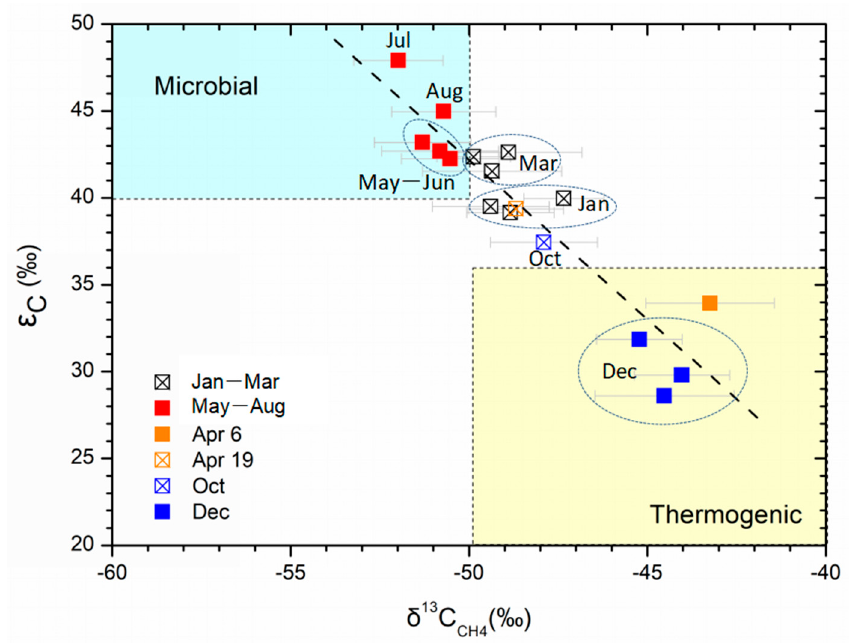
Figure 8. Carbon isotopic composition of wetland methane emission showing the seasonal variation of soil-emitted methane source derived from microbial and thermogenic origins.